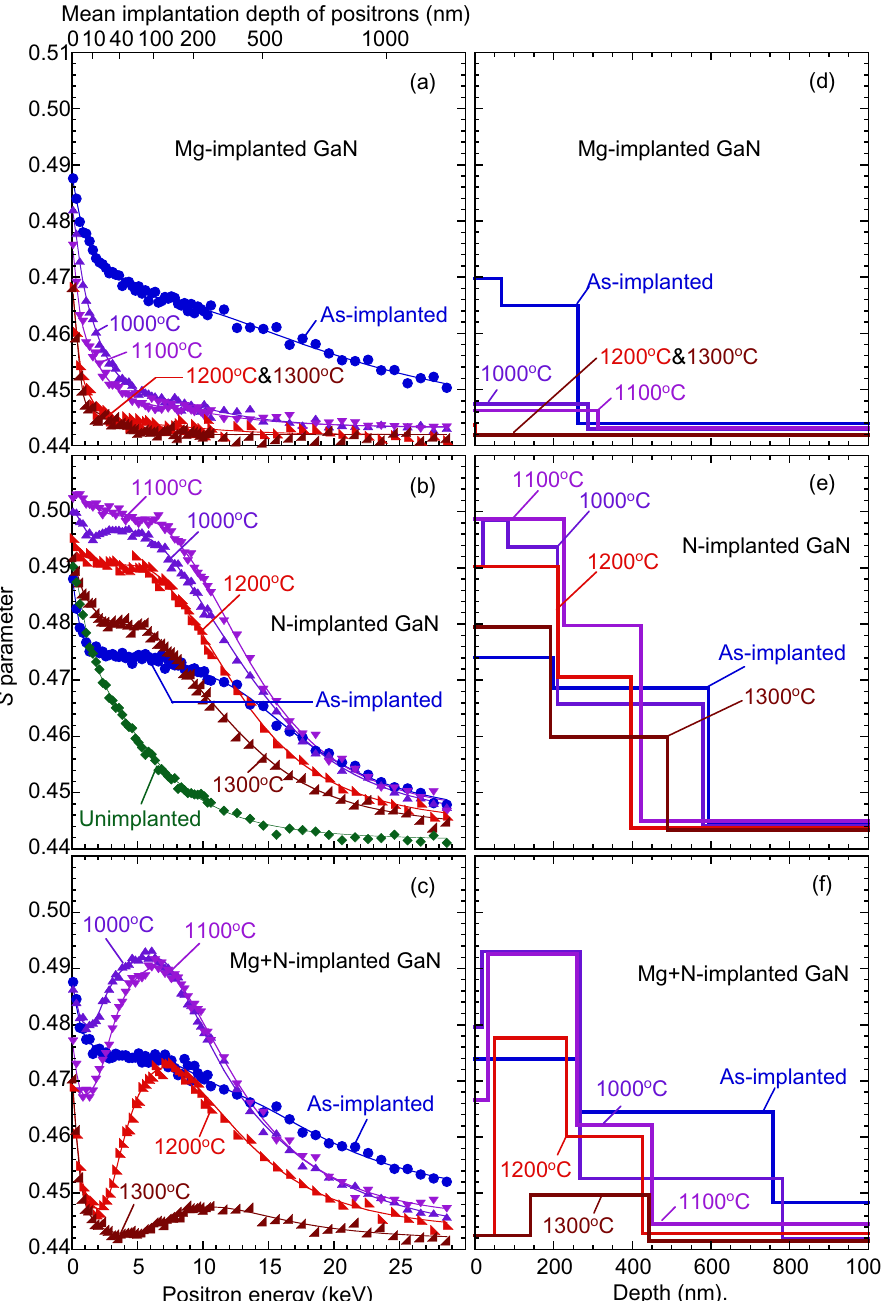
Figure 3. S parameters as function of incident positron energy E for ( a ) Mg-implanted GaN, ( b ) N-implanted GaN, and ( c ) Mg-implanted GaN with N-implantation. S – E curve for unimplanted GaN is shown in ( b ). Annealing temperatures (1000–1300 °C) are shown in figure. Depth distributions of S obtained from analysis of S – E curves shown in ( d ), ( e ), and ( f ),